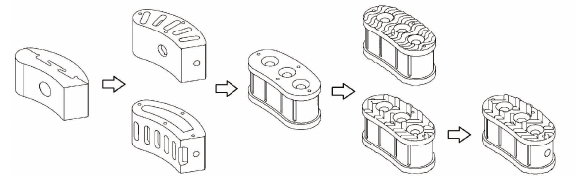
Figure 3: Evolution of lumbar cage design concepts. Table 2: Fused Deposition Modeling process